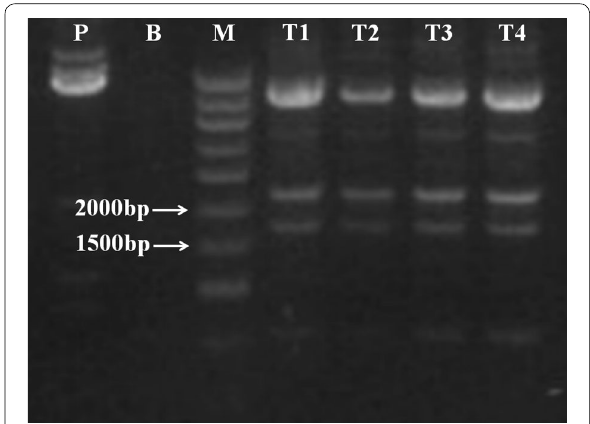
Fig. 5 P plasmid pCAMBIA1303, B blank control, M DNA ladder marker, T1–T4 different transformed D. salina cells